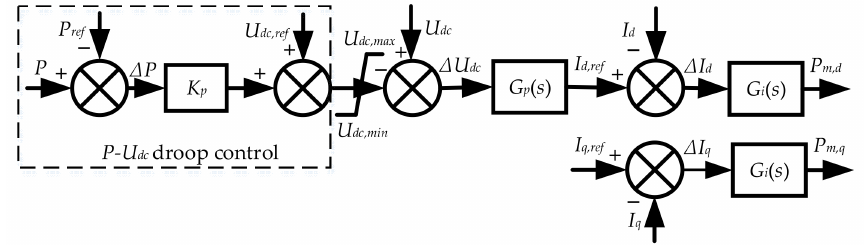
Figure 2. Converter control block